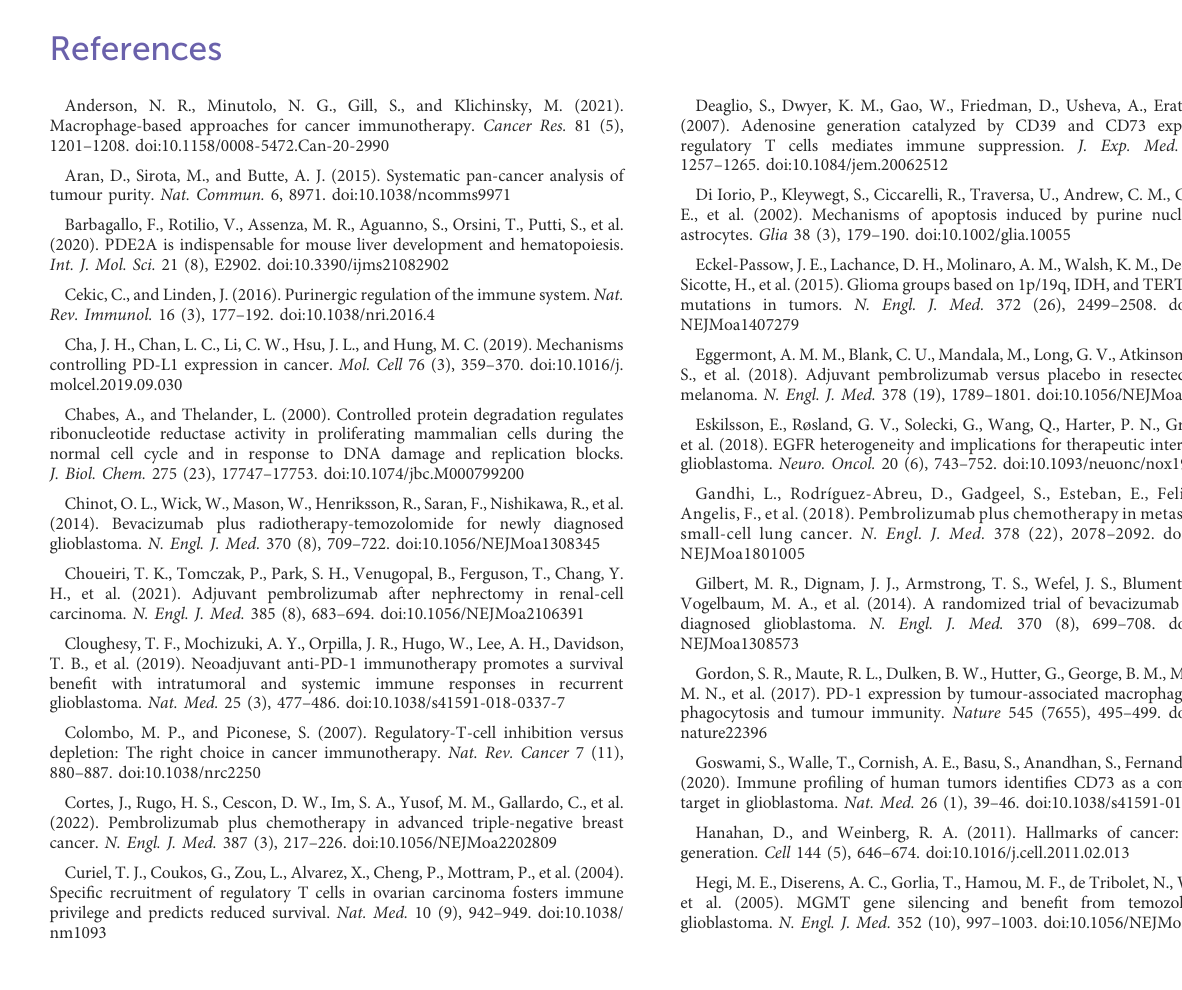
SUPPLEMENTARY FIGURE S1 (A) Distribution of maximum FPKM values of genes in the TCGA dataset between 0 – 100. (B) Distribution of maximum FPKM values of genes in the TCGA dataset between 0 – 1. (C) Differences in the expression of 136PuMGsbetweentwoconsensusclusters.* P < 0.05;** P < 0.01;*** P < 0.001; **** P < 0.0001. SUPPLEMENTARY FIGURE S2 Differences in the clinicopathological features between two consensus clusters. * P < 0.05; ** P < 0.01; *** P < 0.001; **** P < 0.0001. SUPPLEMENTARY FIGURE S3 Representative immunohistochemical staining for POLR1D and PDE2A from the Human Protein Atlas. (A) Representative IHC staining for POLR1D in high- and low-grade gliomas (https://www.proteinatlas. org/ENSG00000186184-POLR1D/, antibody: HPA039337). (B) Representative IHC staining for PDE2A in high- and low-grade gliomas (https://www.proteinatlas.org/ENSG00000186642-PDE2A/, antibody: CAB009752). SUPPLEMENTARY FIGURE 4 Differences in the clinicopathological features between two PuMRS risk groups. * P < 0.05; ** P < 0.01; *** P < 0.001; **** P < 0.0001. SUPPLEMENTARY FIGURE 5 Differences in immunological characteristics of tumor microenvironment between two PuMRS risk groups in CGGA, REMBRANDT, and WCH cohorts. * P < 0.05; ** P < 0.01; *** P < 0.001; **** P <